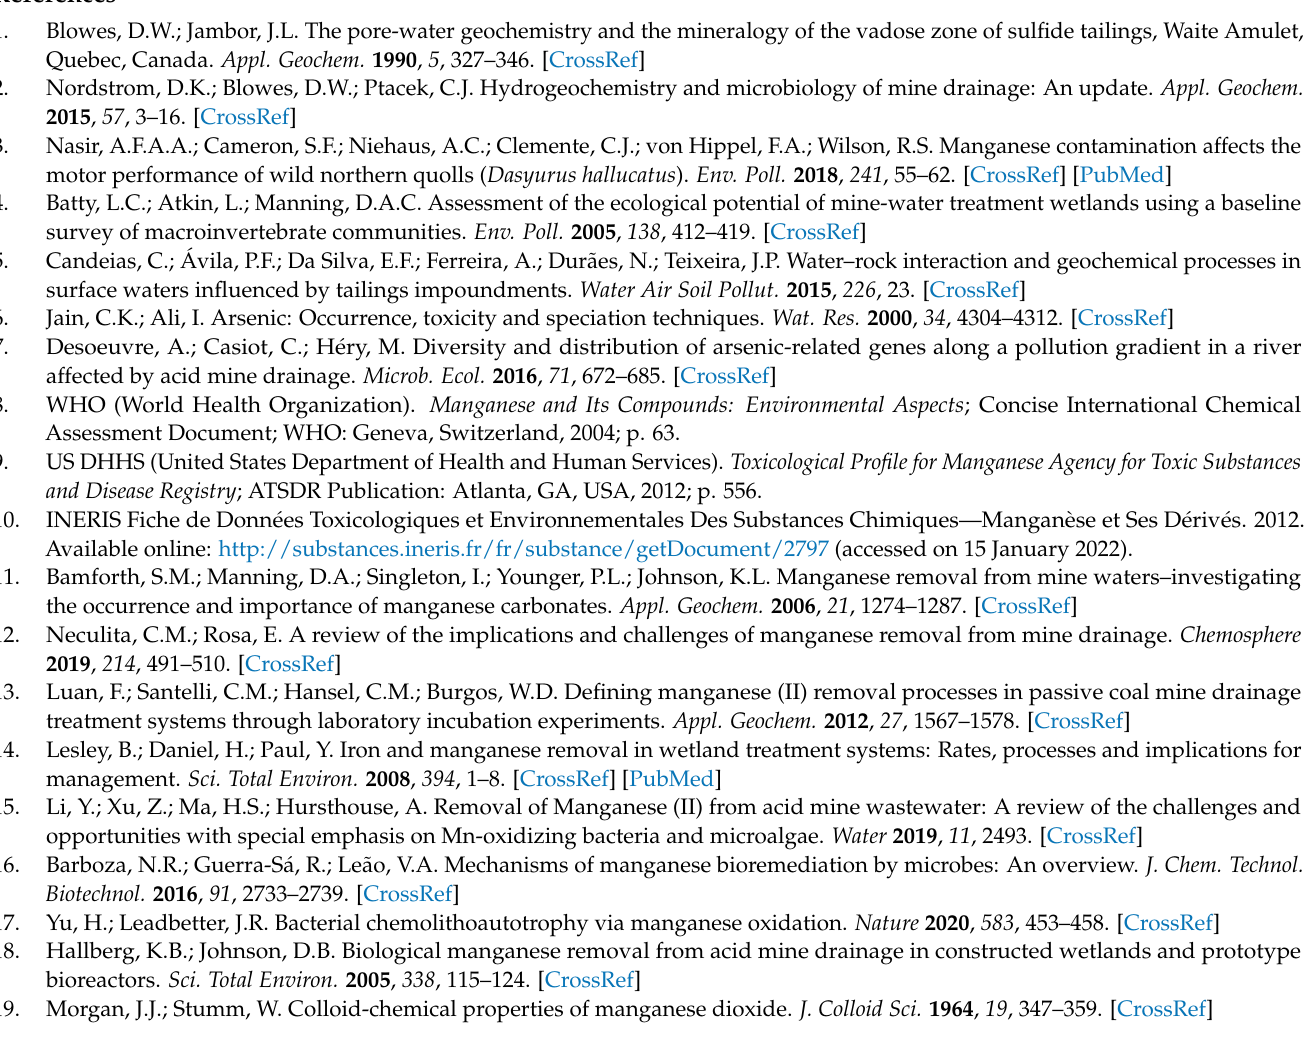
Figure S1: Cumulated frequency of Lop é rec mine water flowrate; Table S2: Lop é rec treatment system performance (dissolved) title; Table S3: Sludge composition. Lop é rec. Figure S2: Total Fe and As